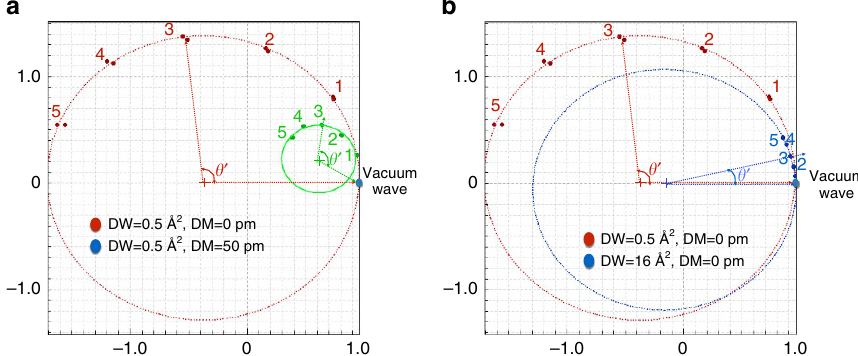
Figure 5 | Effects of mechanical damping and potential softening to Argand plots. ( a ) Red Argand plot shows exit waves reconstructed from simulated images of Au [001] crystal with Debye–Waller (DW) factor of 0.5Å 2 with no mechanical damping (DM), whereas the green Argand plot is obtained from the same crystal but with mechanical damping (DM ¼ 50pm) of the contrast transfer function. The numbers in the plot correspond to number of atom. ( b ) In our case, phases are reduced due to reversible electron beam-induced object excitations in the image formation process. This electron beam stimulation effect is modelled as a higher Debye–Waller factor of 16Å 2 with DM ¼